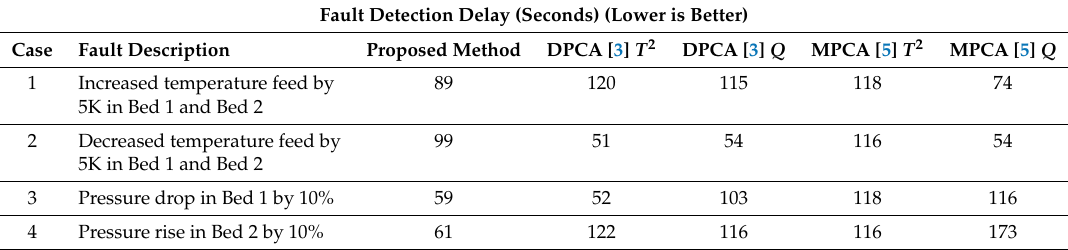
Table 11. Fault detection delay for the PSA system